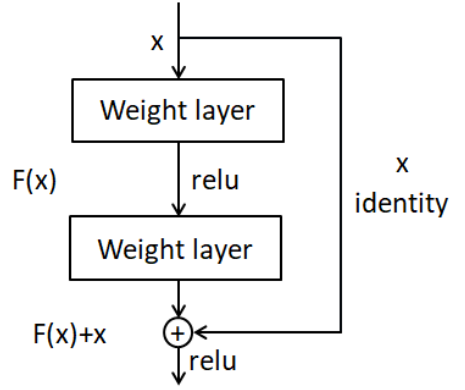
Figure 4. Residual learning: a building